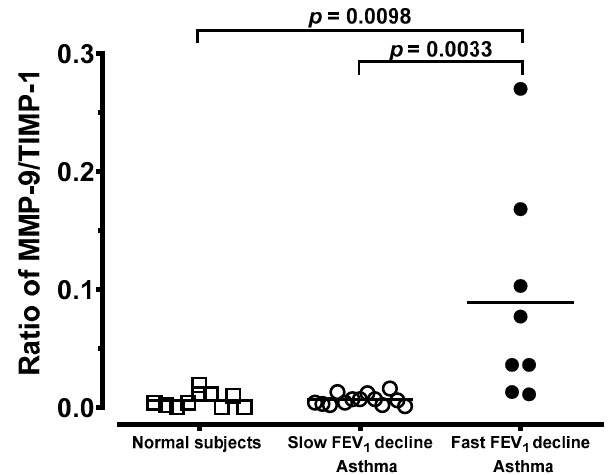
Figure 6. Ratio of MMP-9 to TIMP-1. Data are expressed as the individual value of MMP-9 to TIMP-1 ratio in normal subjects (open square, n = 10), chronic asthma with a slow FEV 1 decline (open circle, n = 13), and chronic asthma with a fast FEV 1 decline (solid circle, n = 8). The p values are presented.